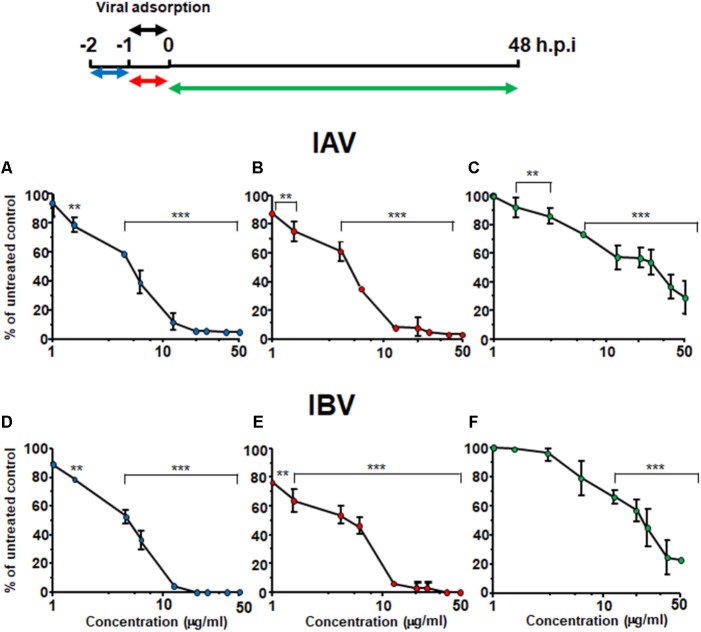
Oximacro® acts in an early stage of IV-replicative cycle. A schematic summary of the time-of-addition experiment is shown at the top of the figure. Accordingly, MDCK cell monolayers were left untreated or treated with different concentrations of Oximacro® from -2 to -1 h (pre-adsorption) (A,D) or from -1 to 0 h (adsorption) (B,E) before infection with IAV or IBV (40 PFU/well). In the post-adsorption treatment (from 0 to 48 h p.i.) (C,F), untreated and infected cells were exposed to the same concentrations of Oximacro® as indicated in the scheme on the top and were infected with IAV or IBV (40 PFU/well) at -1 h p.i. At 48 h p.i., plaques were stained and microscopically counted. Data represent means ± SD (error bars) of three independent experiments performed in duplicate. For each experimental condition, statistical analysis was carried out by comparing treated samples with the untreated control (100% infection). ∗∗∗p < 0.001, ∗∗p < 0.01, and ∗p < 0.05.